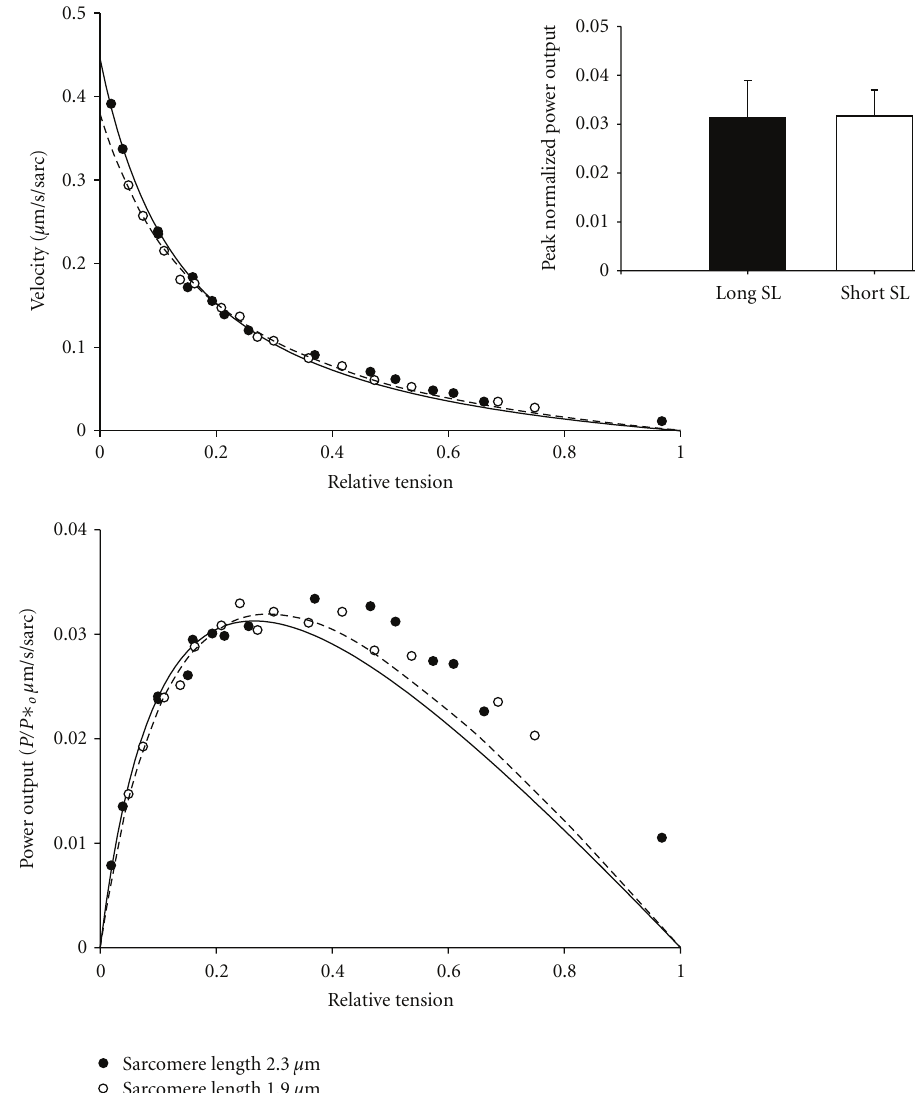
Figure 4: Normalized force-velocity and power-load curves from a pig left ventricular myocyte preparation at long and short sarcomere length obtained during half-maximal Ca 2+ activations. Pig cardiac myocyte preparations exhibited little sarcomere length dependence of loaded shortening and power output. Inset shows bar plot (mean ± SD) of peak normalized power output at long ( ∼ 2.30 μ m) and short ( ∼ 1.90 μ m) sarcomere length ( n = 8 myocyte